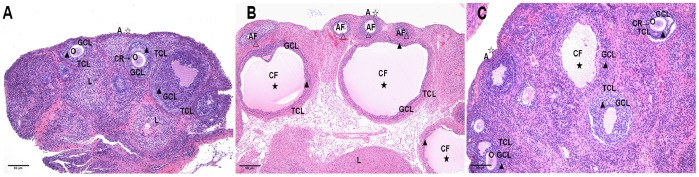
The morphological changes of the rats’ ovarian tissues in the control, PCOS, and PCOS EA groups.The morphological changes of the rats’ ovarian tissues were stained with hematoxylin and eosin, as described in the Materials and Methods section. A) A representative rat’s ovarian tissue section from the control group, which had normal appearance (A×100). B) A representative rat’s ovarian tissue section from the PCOS group showed thickening surface albuginea, under which there were many follicles in different phases (including atretic follicles and cystic dilating follicles), as well as fewer layers of granular cells, disappeared oocytes and corona radiating within the follicles (B×100). C) A representative rat’s ovarian tissue section from the PCOS EA group, which showed preantral and antral follicles, increased granular cell layers, and some ovulation phenomena (C×100). A: albuginea, AF: atretic follicle, CF: cystic follicle, CR: corona radiate, GCL: granular cell layer, L: luteal, O: oocyte, TCL: theca cell layer. ☆ indicated the changes of albuginea, ★ indicated the appearances of cystic follicle, △ indicated the appearances of atretic follicle, ▴ indicated the changes of granular cells layer. Scale bar, 50 µm.